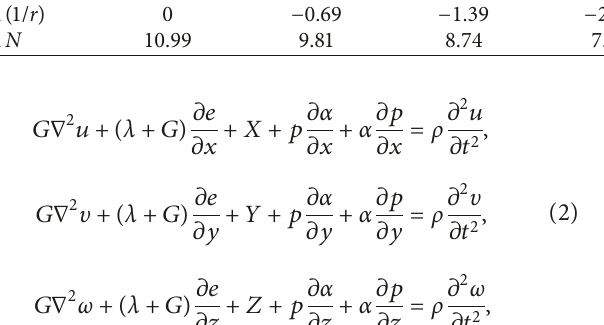
Table 8: List for calculating D